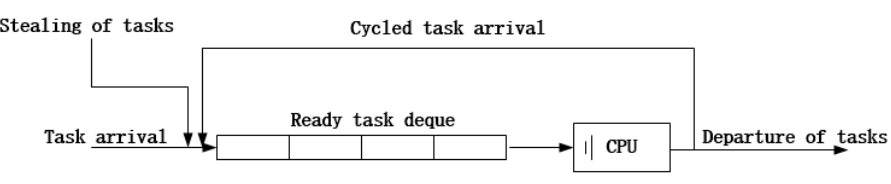
Figure 7. Under-loaded FCN model ( p > 1).